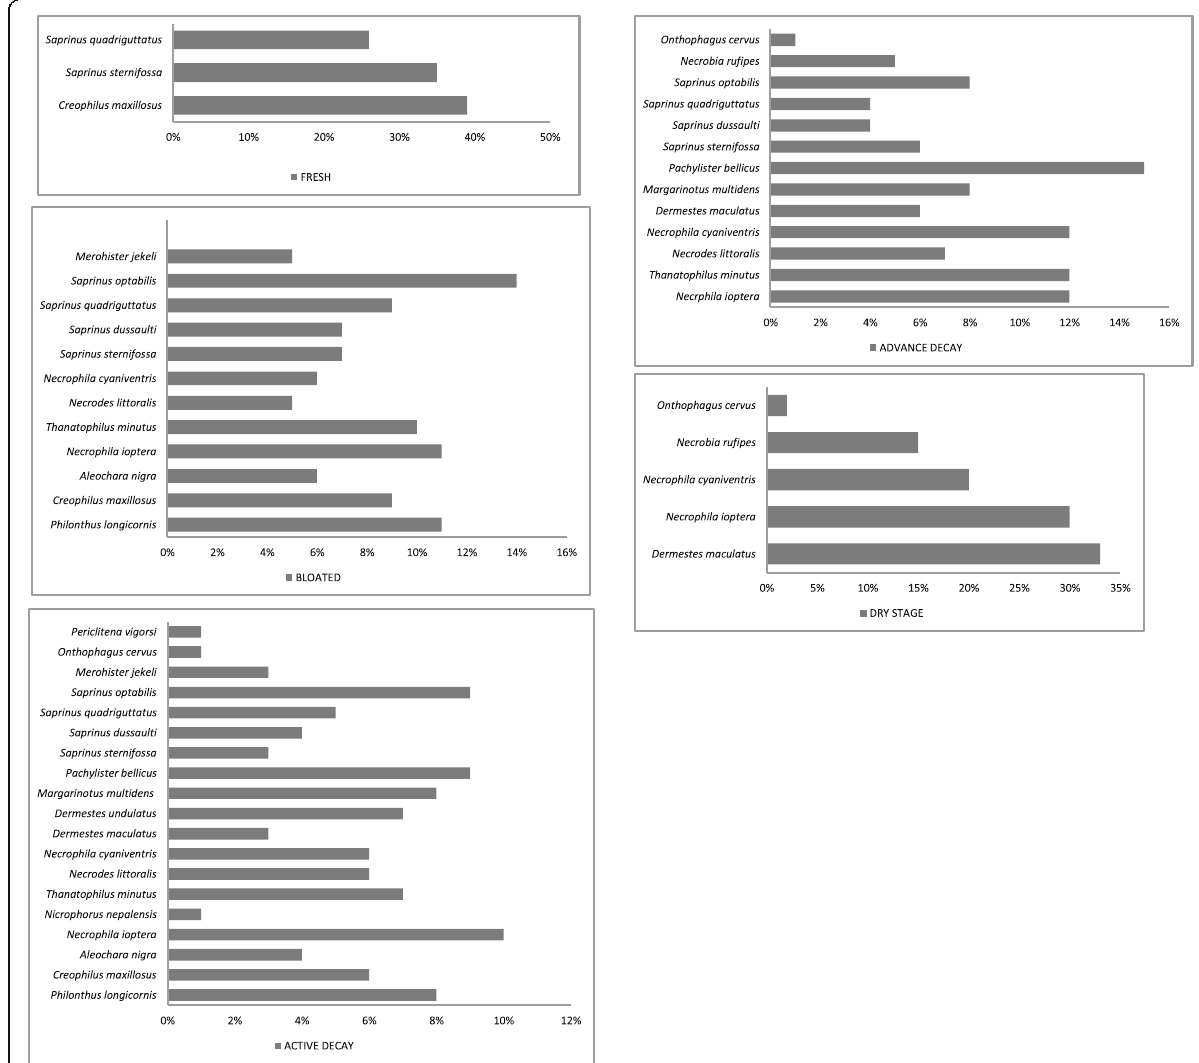
Fig. 2 Composition of Coleoptera (species) during five decomposition stages. These charts explain the percentage of each species found at every stage of decomposition during